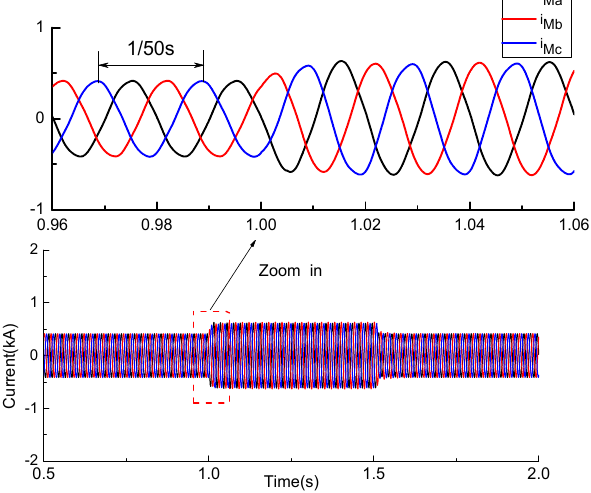
Figure 16. Current waveforms of the secondary side system.